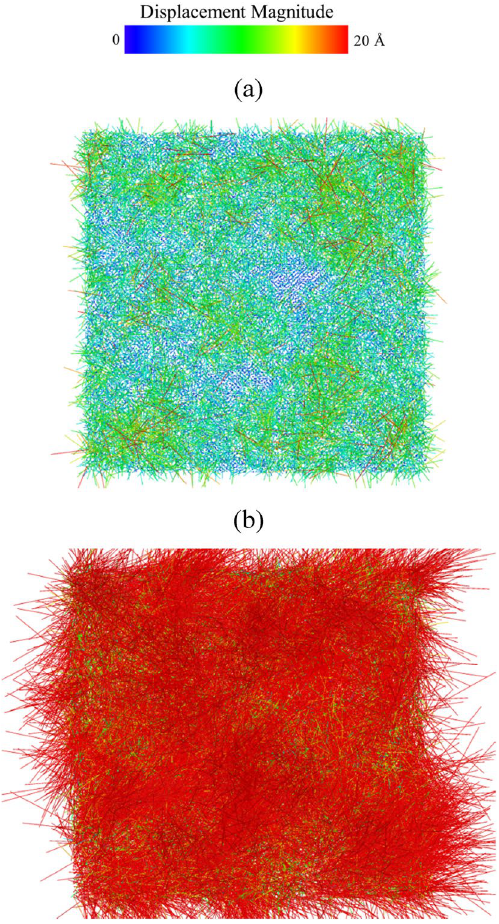
Figure 10. The atomic displacement vectors of the single crystal Nb 20.6 Mo 21.7 Ta 15.6 W 21.1 V 21.0 RHEA at ( a ) the melting point of 2940 K and ( b ) 3110 K. The atom positions at 300 K were used as the reference positions for calculating the atomic displacement